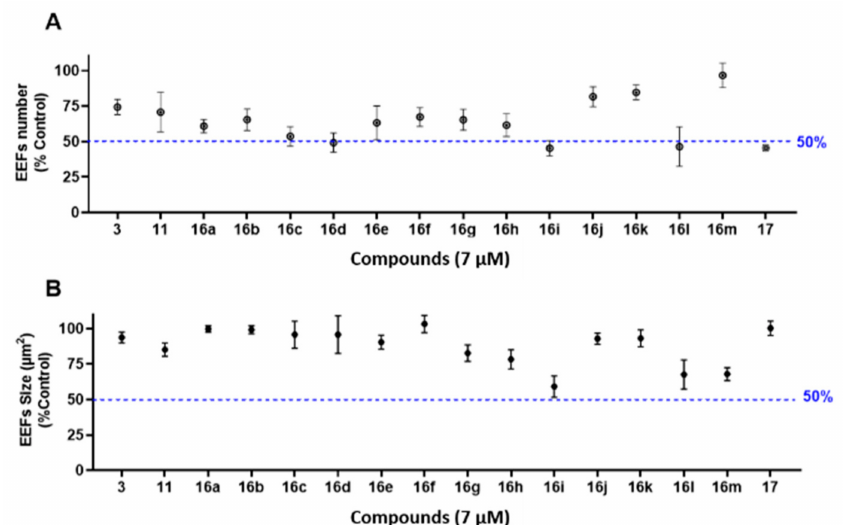
Figure 6. Normalized EEF number ( A ) and EEF size ( B ) in PHH- Pb -GFP at the arbitrary cut-off value of 7 µ M for the indicated compounds. Each point ( • ) represents the average EEF number of four technical replicates. The error bars represent the interval of variability between EEF numbers. These results were obtained from four technical